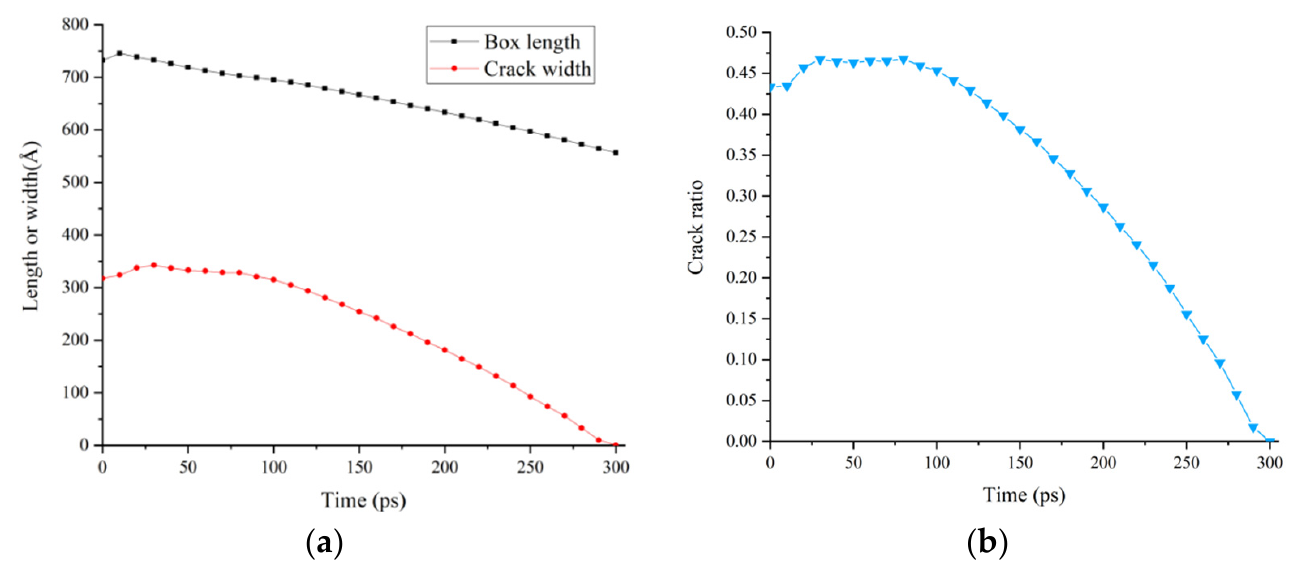
Figure 11. Healing degree parameters of the model in the process of self-healing. ( a ) Crack width and box length; ( b ) Crack ratio.